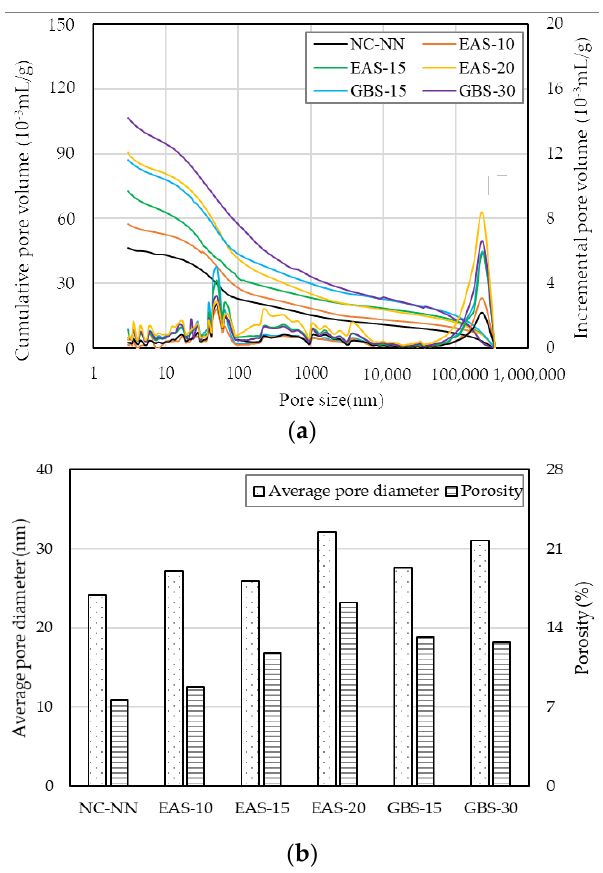
Figure 4. Pore size distribution of HSC at 28 days: ( a ) comparison of cementitious materials replacement ratios; ( b ) porosity and average pore size of the selected composite.